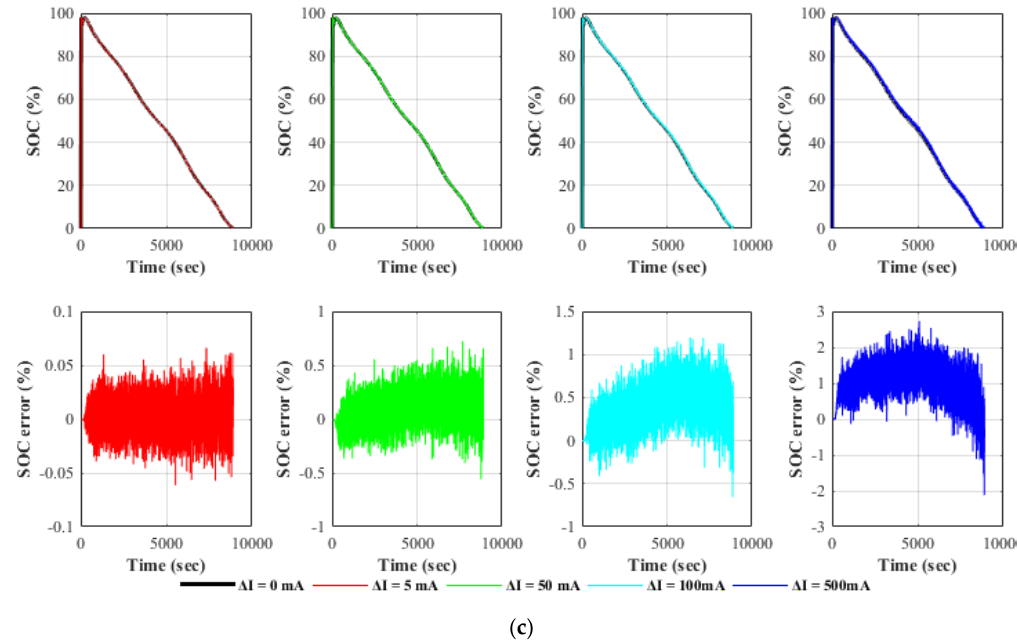
Figure 8. Estimated values at different precision of current sensors: ( a ) model parameters; ( b ) estimated OCV; ( c ) estimated SOC.